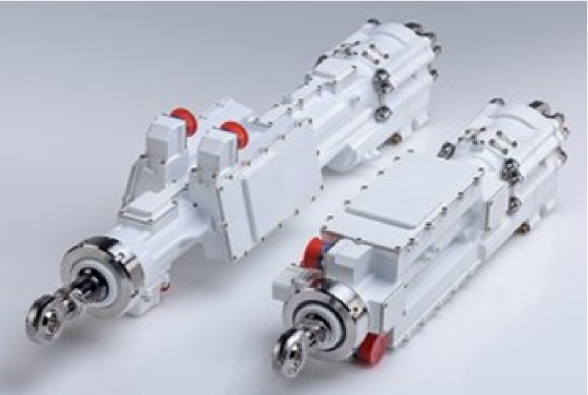
Figure 19. LGER EMAs for Vertical Take-Off and Landing (VTOL), courtesy of Umbra Group.